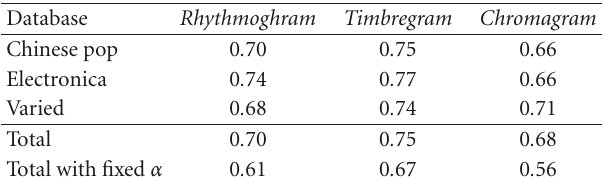
Table 2: F 1 of the three databases for the segmentation using the rhythmogram , timbregram , and chromagram